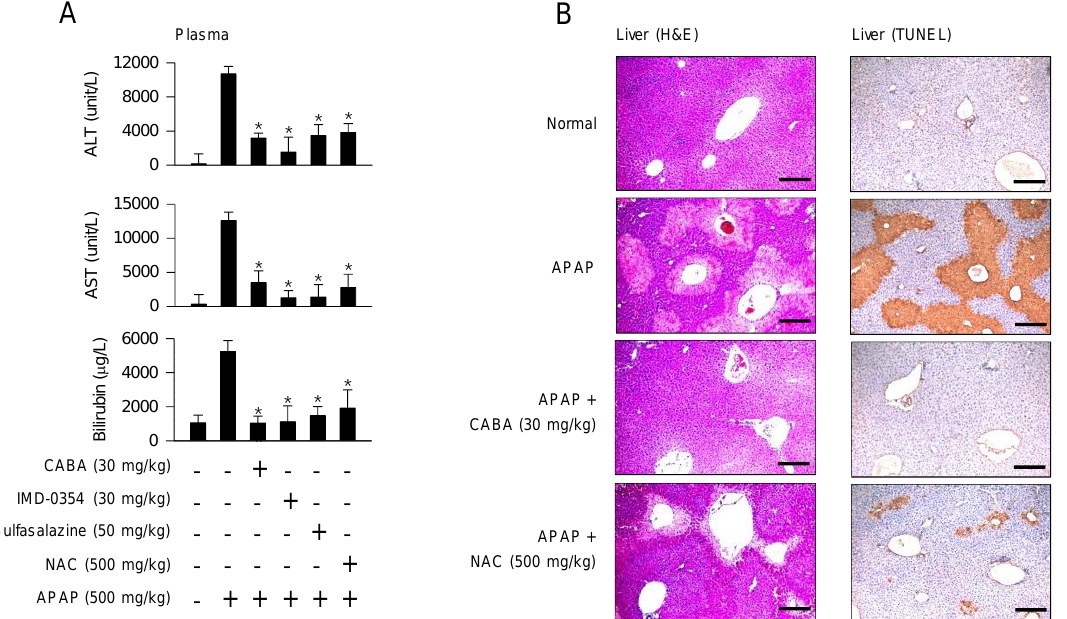
Figure 3. Effect of IKKβ inhibitors on APAP-induced hepatic injury. C57BL/6 mice were treated with CABA at 1 h after APAP overdose. ( A ) Blood samples were prepared at 15 h, and used to measure the levels of ALT, AST, and bilirubin. * p < 0.05 vs. APAP alone. ( B ) Liver lobules were biopsied after 15 h. Liver tissues were sectioned into sections with a thickness of 5 µm, stained with H&E or reacted with the TUNEL assay kit, and then examined under microscope. Black scale bars are 200 µm.